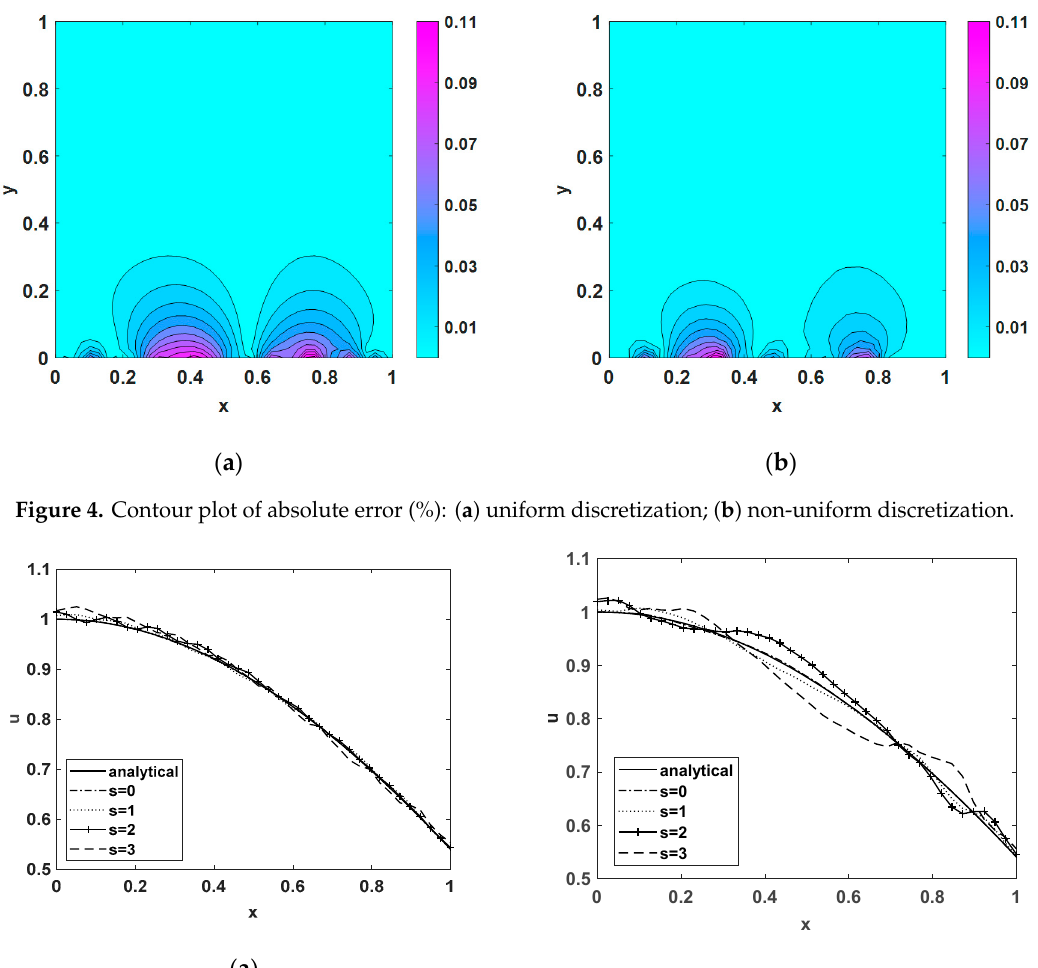
Figure 3. Non-uniform discretization using